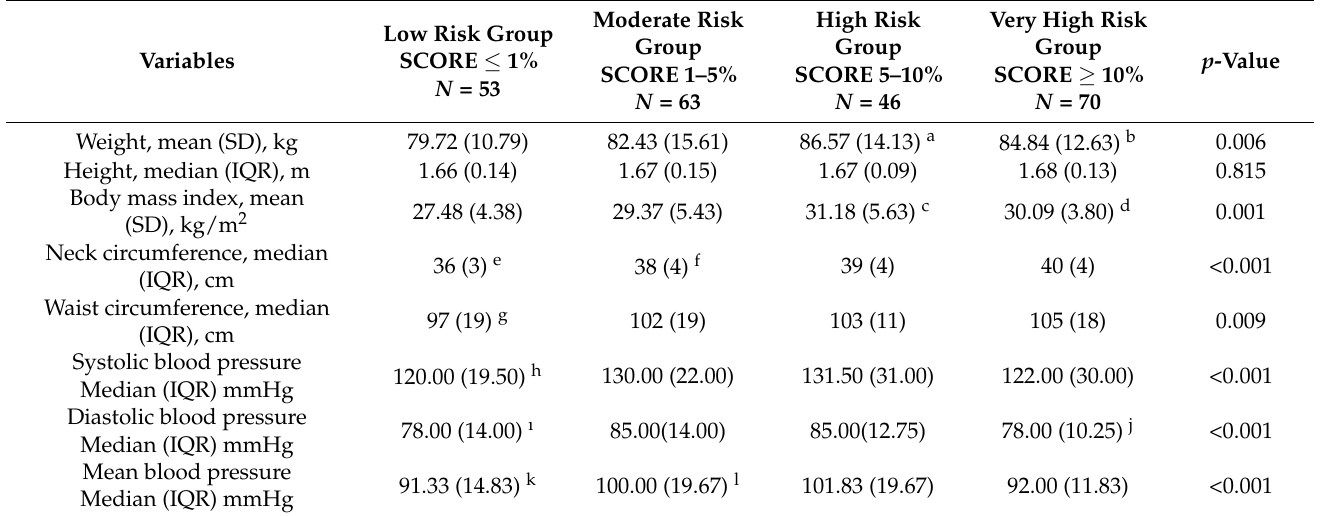
Table 4. Anthropometric and blood pressure measurements of patients by SCORE risk